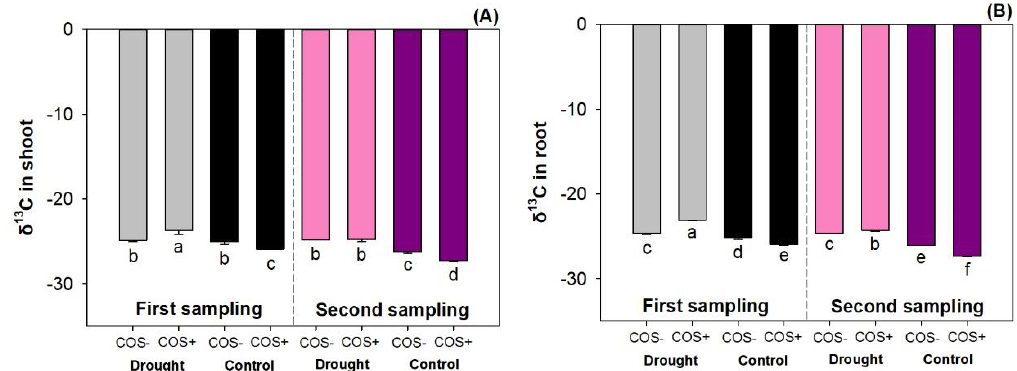
Figure 6. Delta carbon-13 abundance in shoots ( A ) and roots ( B ) in two harvests of Buddhist pine ( Podocarpus macrophyllus ) seedlings exposed to chitosan oligosaccharide (COS) addition (COS- vs. COS+) under contrasting water availabilities (drought vs. irrigated control). Different letters indicate a significant difference according to Tukey’s test at the 0.05 level. Error bars stand for standard errors.